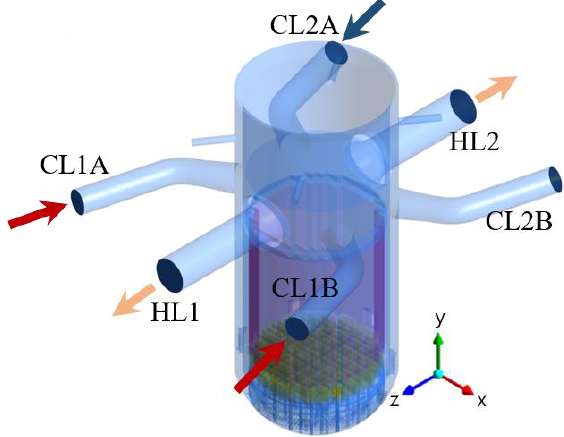
Figure 5. Schematic domain of reactor vessel of APR1400 (CL: cold-leg, HL: hot-leg). Table 1. Initial transient conditions for CFD calculation.